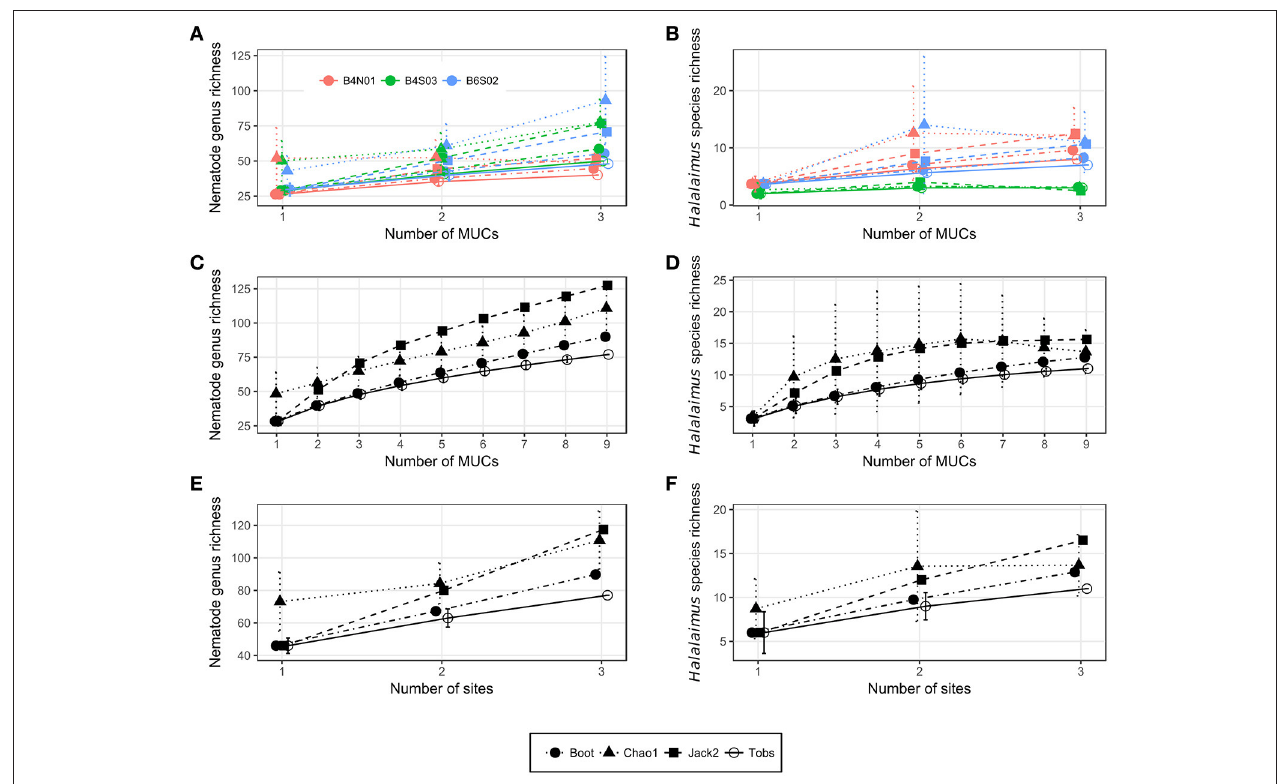
FIGURE 5 | Nematode genus (A,C,E) and Halalaimus species (B,D,F) accumulation curves for (A,B) all MUCs taken per site, (C,D) all MUCs taken, and (E,F) all sites sampled during GSRNOD15A. Error bars denote standard deviations and are only provided for T obs and Chao1 in the PRIMER v6 software. Boot, Bootstrap; Jack2, Jackknife 2; T obs , observed taxon richness.